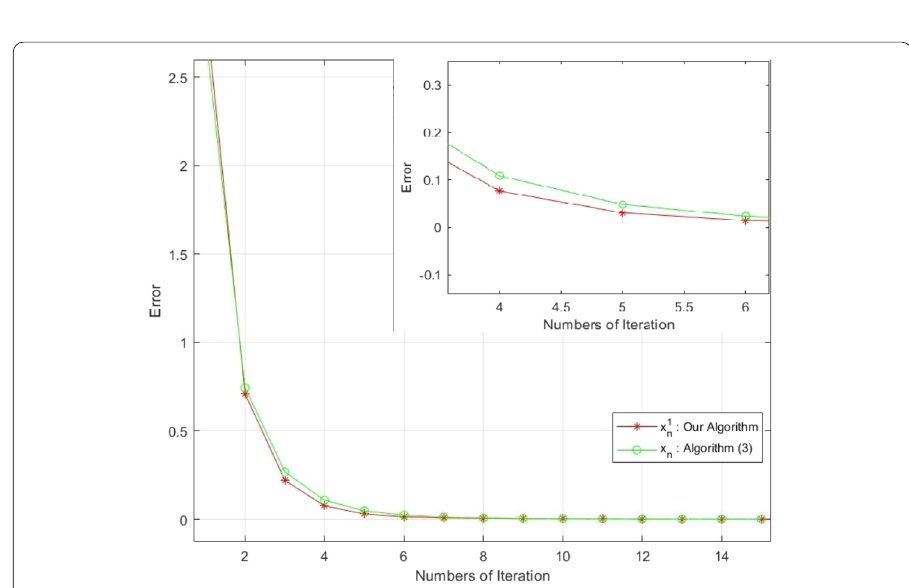
Figure 3 Comparison between Algorithms (21) and (3) for Example 3 with u = 3 and N =